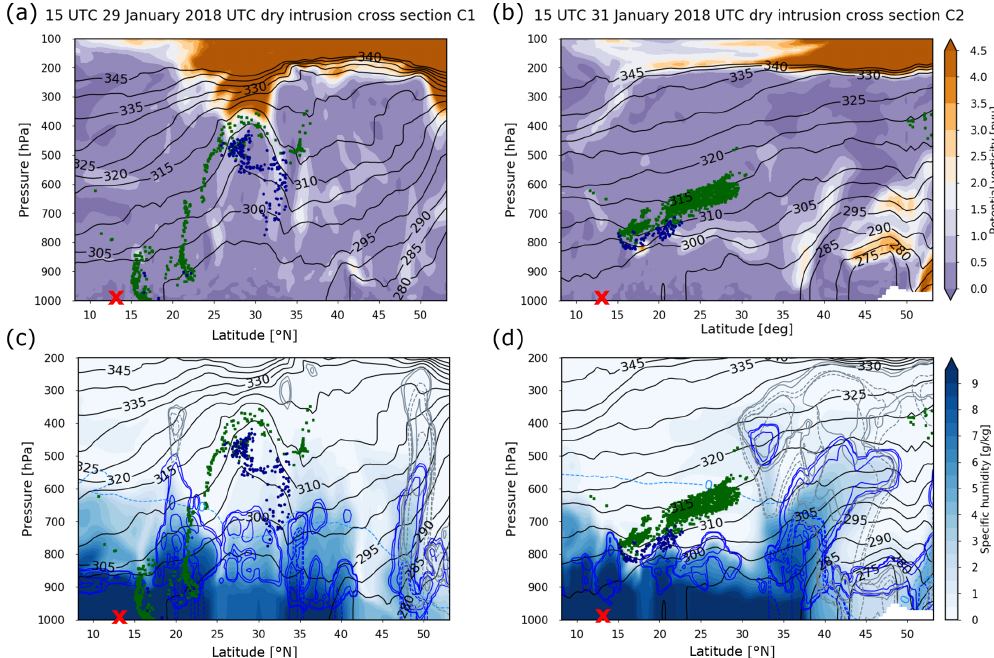
Figure 14. Meridional cross-sections along the lines C1 and C2 in Fig. 11b at 15:00UTC on 29 January 2018 through the upper-level cut-off (C1; a, c ) and at 15:00UTC on 31 January 2018 showing the strongly descending air parcels west of the cut-off (C2; b, d ). Filled contours show (a, b) potential vorticity and (c, d) specific humidity. Isentropes are shown by black contours every 5K. In (c, d) cloud liquid water is shown by solid blue contours, rainwater by dashed blue contours, ice water content by grey contours and snow water content by dashed grey contours. All hydrometeor contour lines correspond to 5, 10 and 50mgkg − 1 . The green and blue points correspond to the positions of air parcels within ± 1 ◦ longitude of the cross-section. The green air parcels form together the cloud layer (940–700hPa), and the blue air parcels form the sub-cloud layer (surface to 940hPa) above Barbados during the period of the extratropical dry intrusion between 1–4 February 2018. The latitude of Barbados is highlighted by the red cross at the